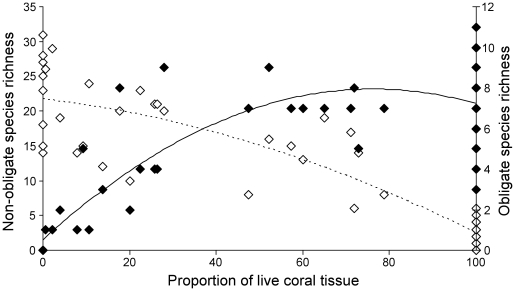
Response of coral obligate and non-obligate decapod species to the loss of live coral tissue.White diamonds and discontinuous line = non-obligate decapod species richness y = −0.0012x
2−0.0737x+21.739; R2 = 0.85, N = 82, p<0.001. Black diamonds and continuous line = coral obligate decapod species richness: y = −0.0013x
2+0.1951x+0.5189 ; R2 = 0.69, N = 82, p<0.001.